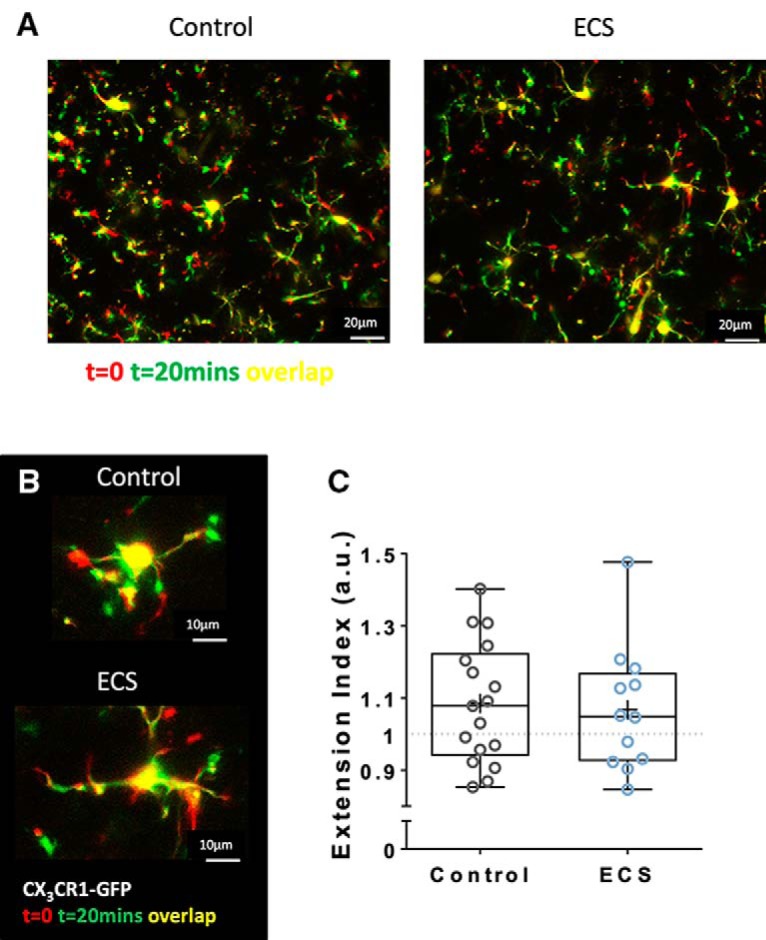
ECS did not affect spontaneous motility of microglia in mouse CA1sr 24 h after seizures. A, B, Representative time-coded images (t = 0 in red, t = 20 min in green, overlap in yellow) of CA1sr fields (A) or single cells (B) from slices from control (right/top) and ECS (left/bottom) treated animals. C, ECS had no effect on mean EI (area of extensions/area of retractions) after 20 min of imaging under baseline conditions: 1.085 ± 0.041 for control slices and 1.067 ± 0.05 for ECS slices.